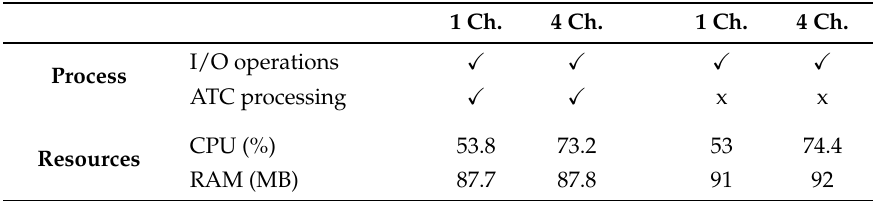
Table 5. RHS resources performance during the Stimulation stage depending on the number of working channels and the FES current definition implementation. The ATC processing has been enabled (standard flow) or disabled (direct ATC-I FES equivalence) in order to study if whether implementation affects the run-time system